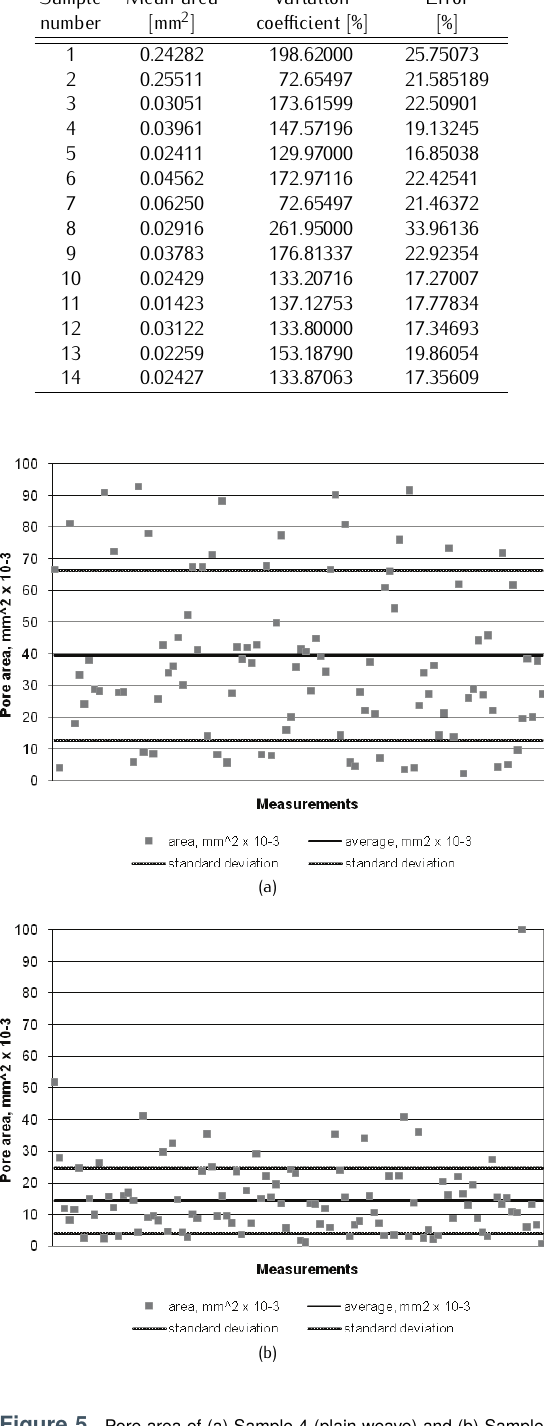
Figure 5. Pore area of (a) Sample 4 (plain weave) and (b) Sample 11 (twill 2/1). The results of the measured mean area are compared with theoretically calculated pore area, on the basis of the equation (1). The comparison of the values is presented on Fig. 6.